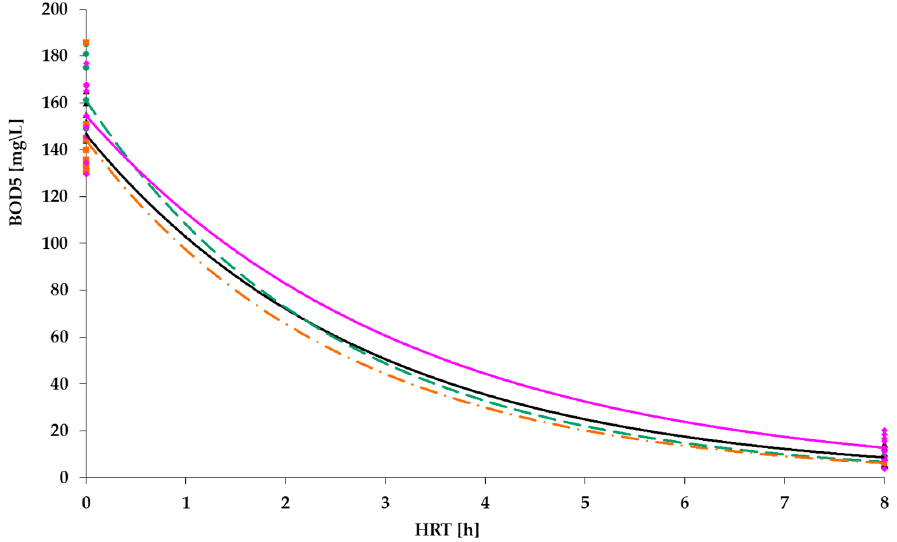
Figure 10. BOD removal dynamics if: floating carrier PV is 10% of reactor volume (black); 20% of tank volume (green); 30% of tank volume (orange); no carrier in the reactor (magenta).